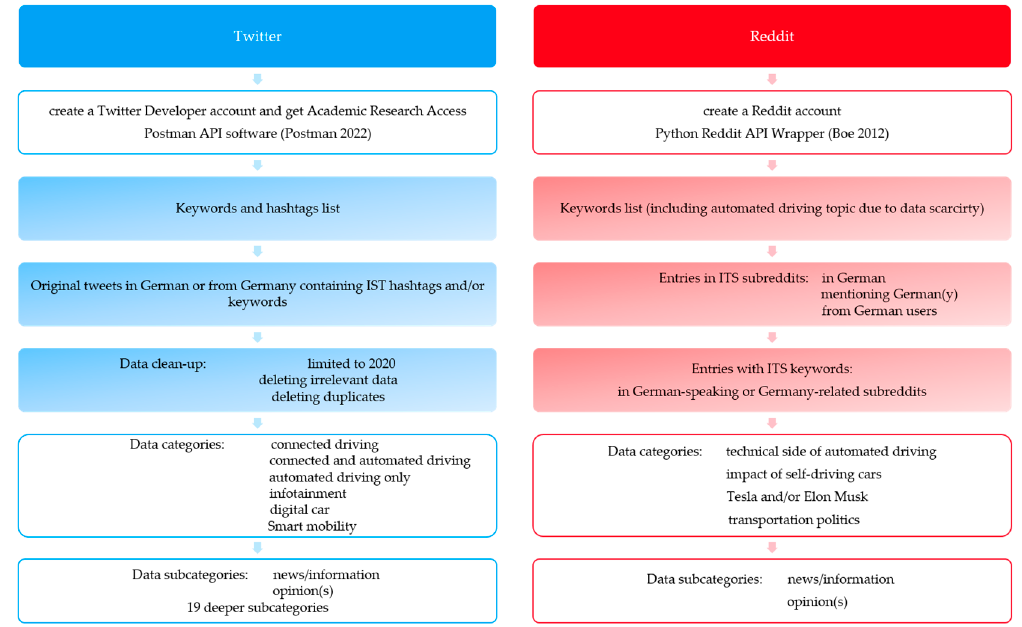
Figure 1. General procedures of data scraping and analysis (Postman 2022; Boe 2012).